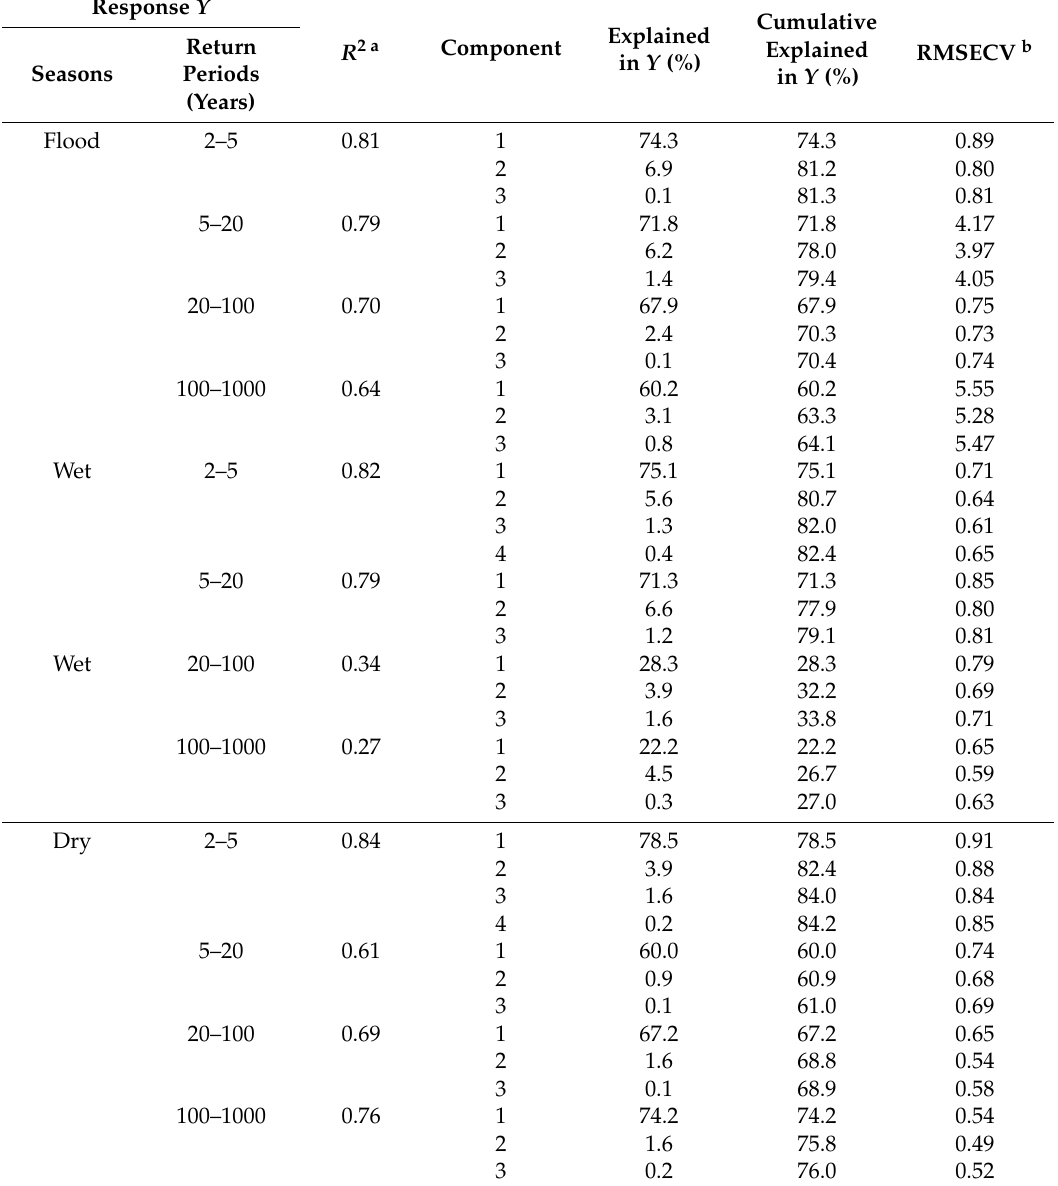
Table 4. Summary of PLS regression for floods in each